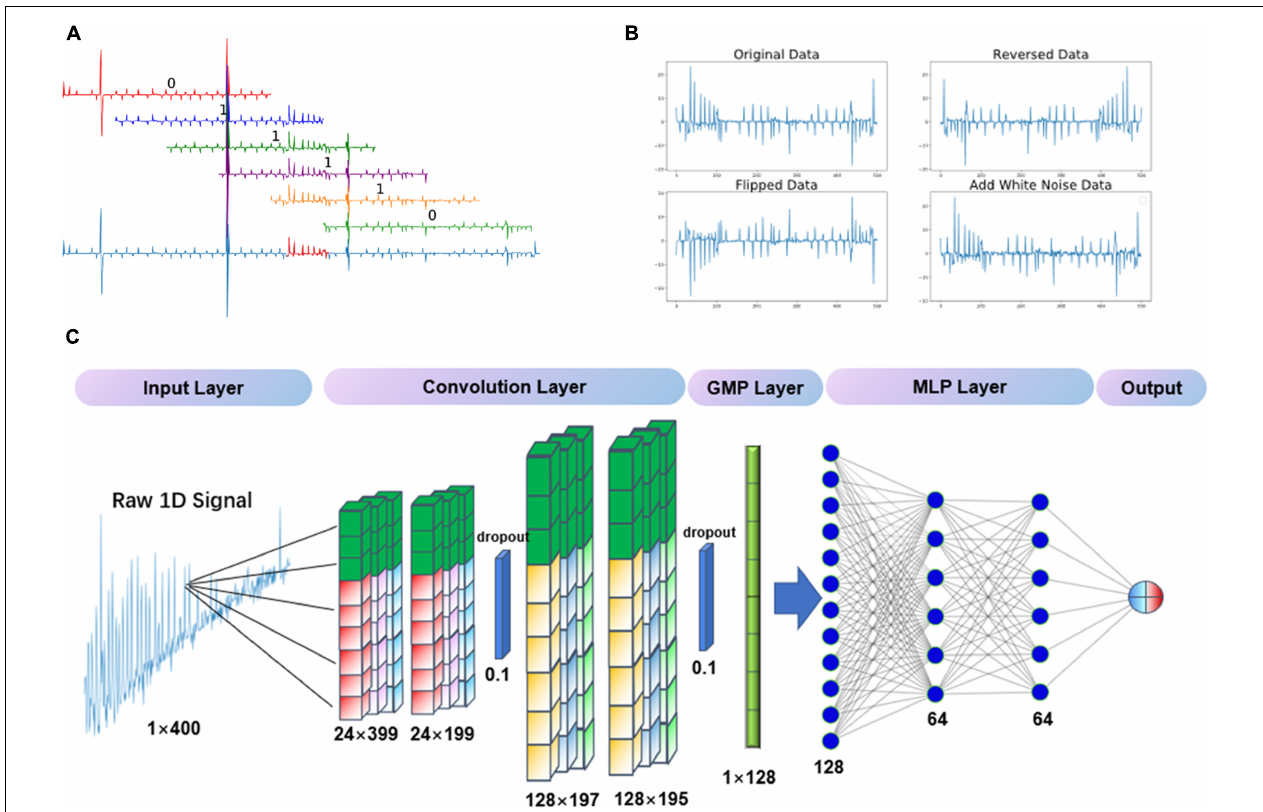
FIGURE 5 | Data pre-processing and the deep learning model for nystagmus detection. (A) The rolling cut of the velocity curve to fix the length of the time series; sub-samples including a nystagmus pattern (marked as red) are labelled as positive (otherwise negative). (B) Data augmentation methods applied to generate new examples of nystagmus. Upper left: Original data with nystagmus signals. Upper right: Data flipped on the x-axis. Bottom left: Data flipped on the y-axis. Bottom right: Add white noise (C) shows the model structures. GMP, global max pooling; MLP, multi-layer perception.